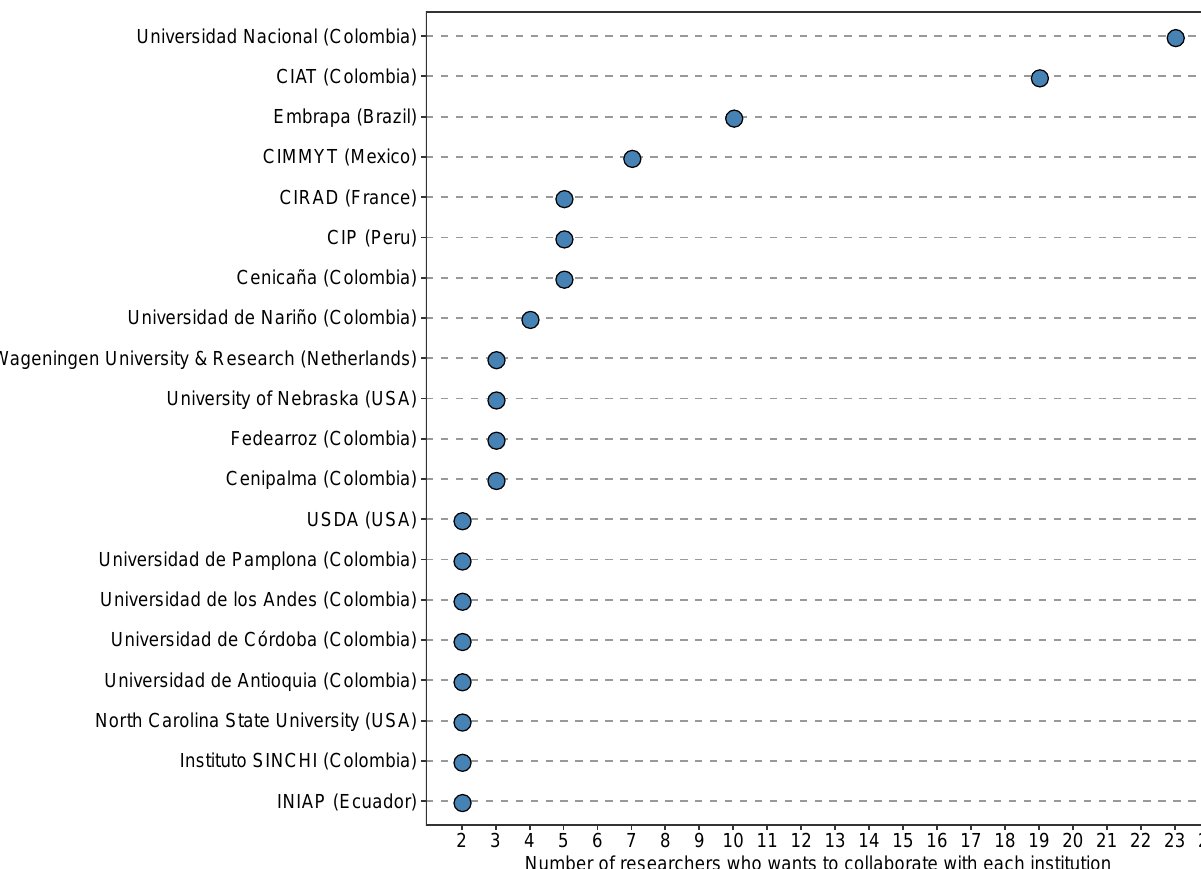
Figure 5. The number of researchers working on plant breeding and plant genetic resources from A GROSAVIA interested in starting collaborative breeding initiatives with each national and international research institution and university listed. In parenthesis is the country where each institution is